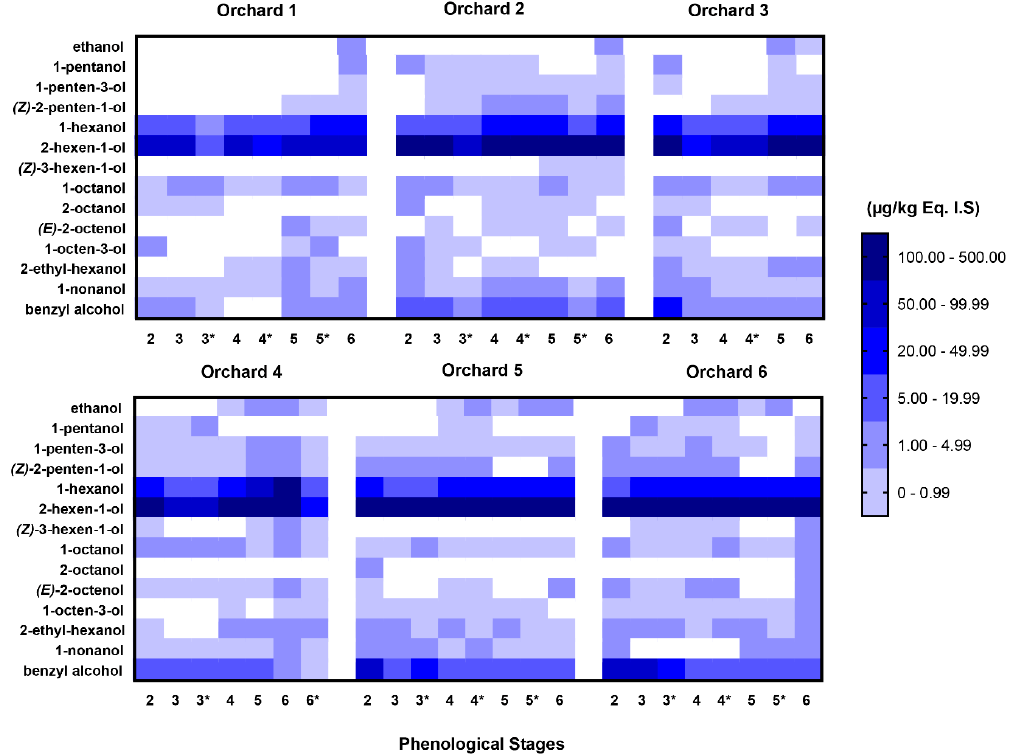
Figure 4. Volatile alcohols concentration in pulped Regina sweet cherries during development in orchards 1 to 6. 3*, 4*, 5* and 6* indicate samples with the herbaceous flavor. White cells mean absent or not detected.